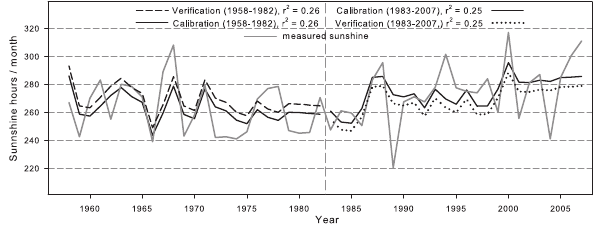
Fig. 4. Time series plots of measured (solid grey line) and recon- structed mean June–July sunshine hours for the calibration and ver- ification periods of the split sample procedure (solid and dashed black line). Table 3. Statistics of calibration/verification procedure between the P. nigra weighted mean chronology and mean June–July sunshine hours; RE – reduction of error; CE – coefficient of efficiency; r 2 – squared regression coefficient or explained variance.